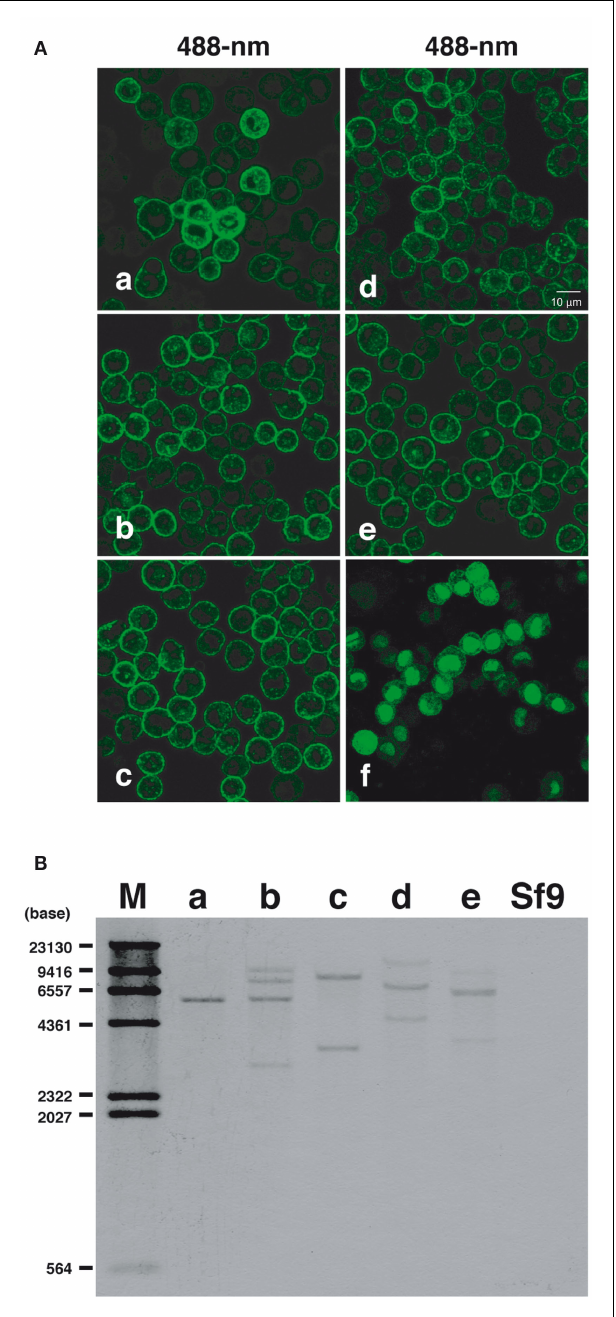
FIGURE 1 | Constitutive expression and genomic integration of PBANR variants in cultured Sf9 cells. (A) Stable cell lines expressing